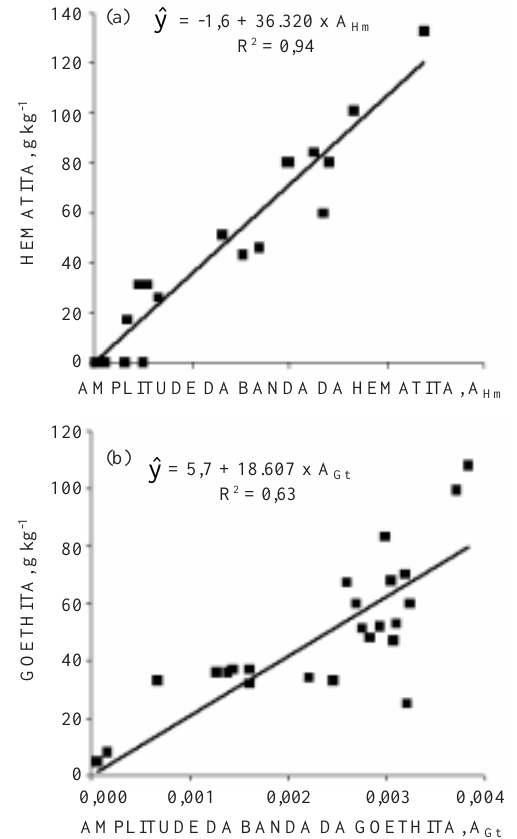
Figura 6. Relação entre teor de (a) hematita e (b) goethita e as amplitudes A e A , respectiva- Hm Gt mente, verificadas nos espectros da segunda derivada da função Kubelka-Munk. As retas indicadas correspondem às equações 1 e 5 obtidas para os minerais correspondentes à TFSA (Quadro 6) (n =